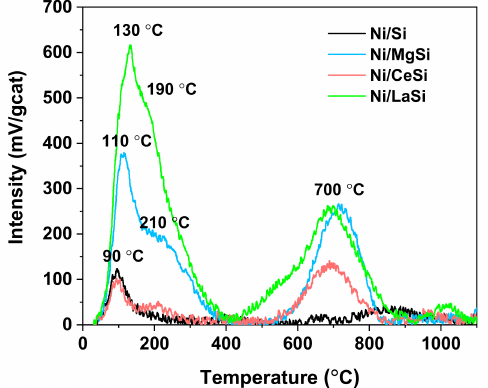
Figure 5. H 2 -TPD profiles of the Ni/Oxide-SiO 2